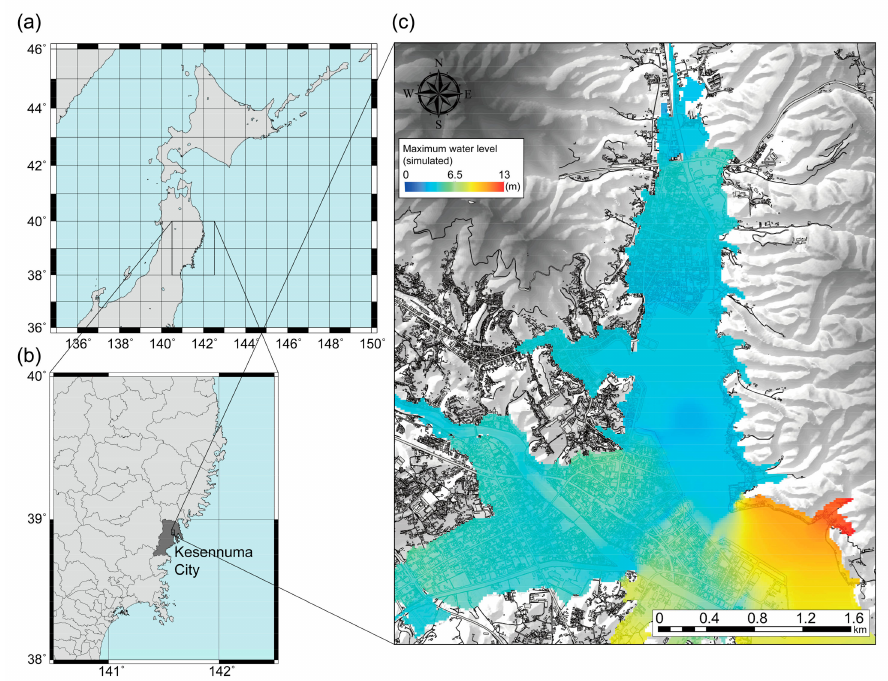
Figure 1. Overview of the study area with the numerical calculation of the 2011 Tohoku tsunami. ( a , b ) Wide-area view of the study area, ( c ) Central part of the study area with the simulated 2011 Tohoku